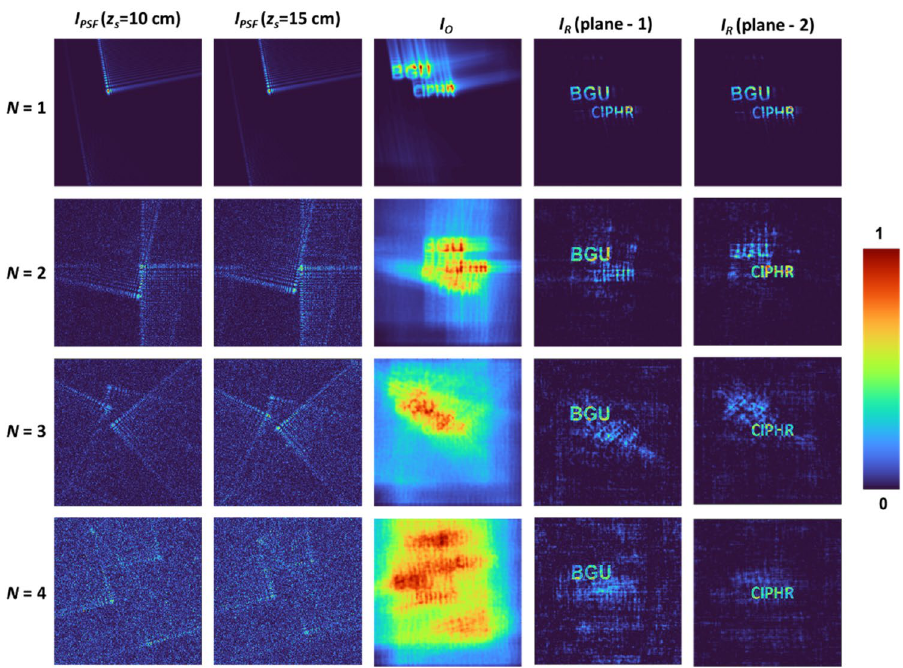
Figure 3. 3D simulation results. Simulation results for two test objects located at two axially separated planes using a different number of Airy beams. z s is the distance between the object and the PM; N —number of Airy beams; I PSF —point spread function; I O —object intensity distribution; I R —reconstructed images. Numerical simulations are performed using MATLAB (version R2020b) 36